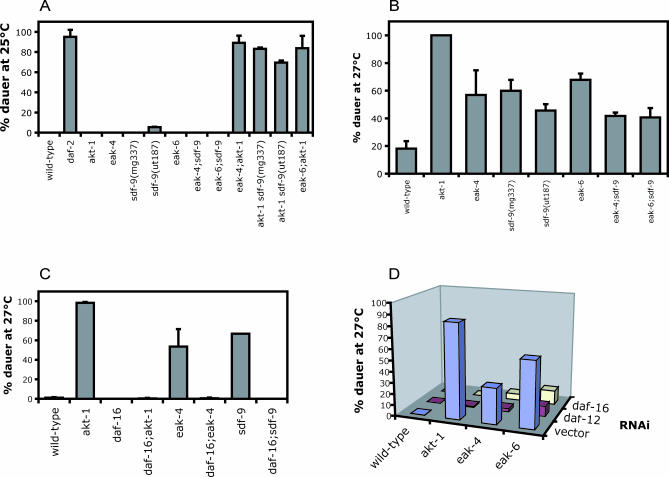
Dauer Formation Phenotypes of eak Mutants
eak single mutants, eak-x;eak-y double mutants, or eak;akt-1 double mutants were assayed for dauer arrest at (A) 25 °C and (B) 27 °C. (C) eak 27 °C dauer arrest phenotypes are suppressed by a mutation in daf-16/FoxO. (D) akt-1, eak-4, and eak-6 27 °C dauer arrest phenotypes are suppressed by RNAi of daf-16/FoxO and daf-12/NHR. All error bars indicate standard deviation. All experiments were performed three times. Refer to Table S1 for numbers of animals scored. eak-5 is allelic to the synthetic dauer formation gene sdf-9 [62] and is referred to as sdf-9 throughout the paper. Mutant alleles used were daf-2(e1370), akt-1(mg306), eak-4(mg348), sdf-9(mg337) and sdf-9(ut187), eak-6(mg329), and daf-16(mgDf47). sdf-9(ut187) was used to construct the eak-4;sdf-9, eak-6;sdf-9, and daf-16;sdf-9 double mutants. Multiple alleles of eak-4 and sdf-9 yielded phenotypes similar to those shown. See Table S1 for numbers of animals assayed.